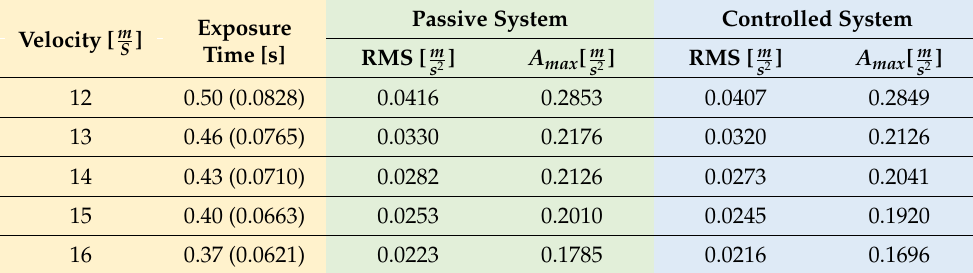
Table 2. The quality indicators of vertical acceleration of the vehicle body in the center of mass.